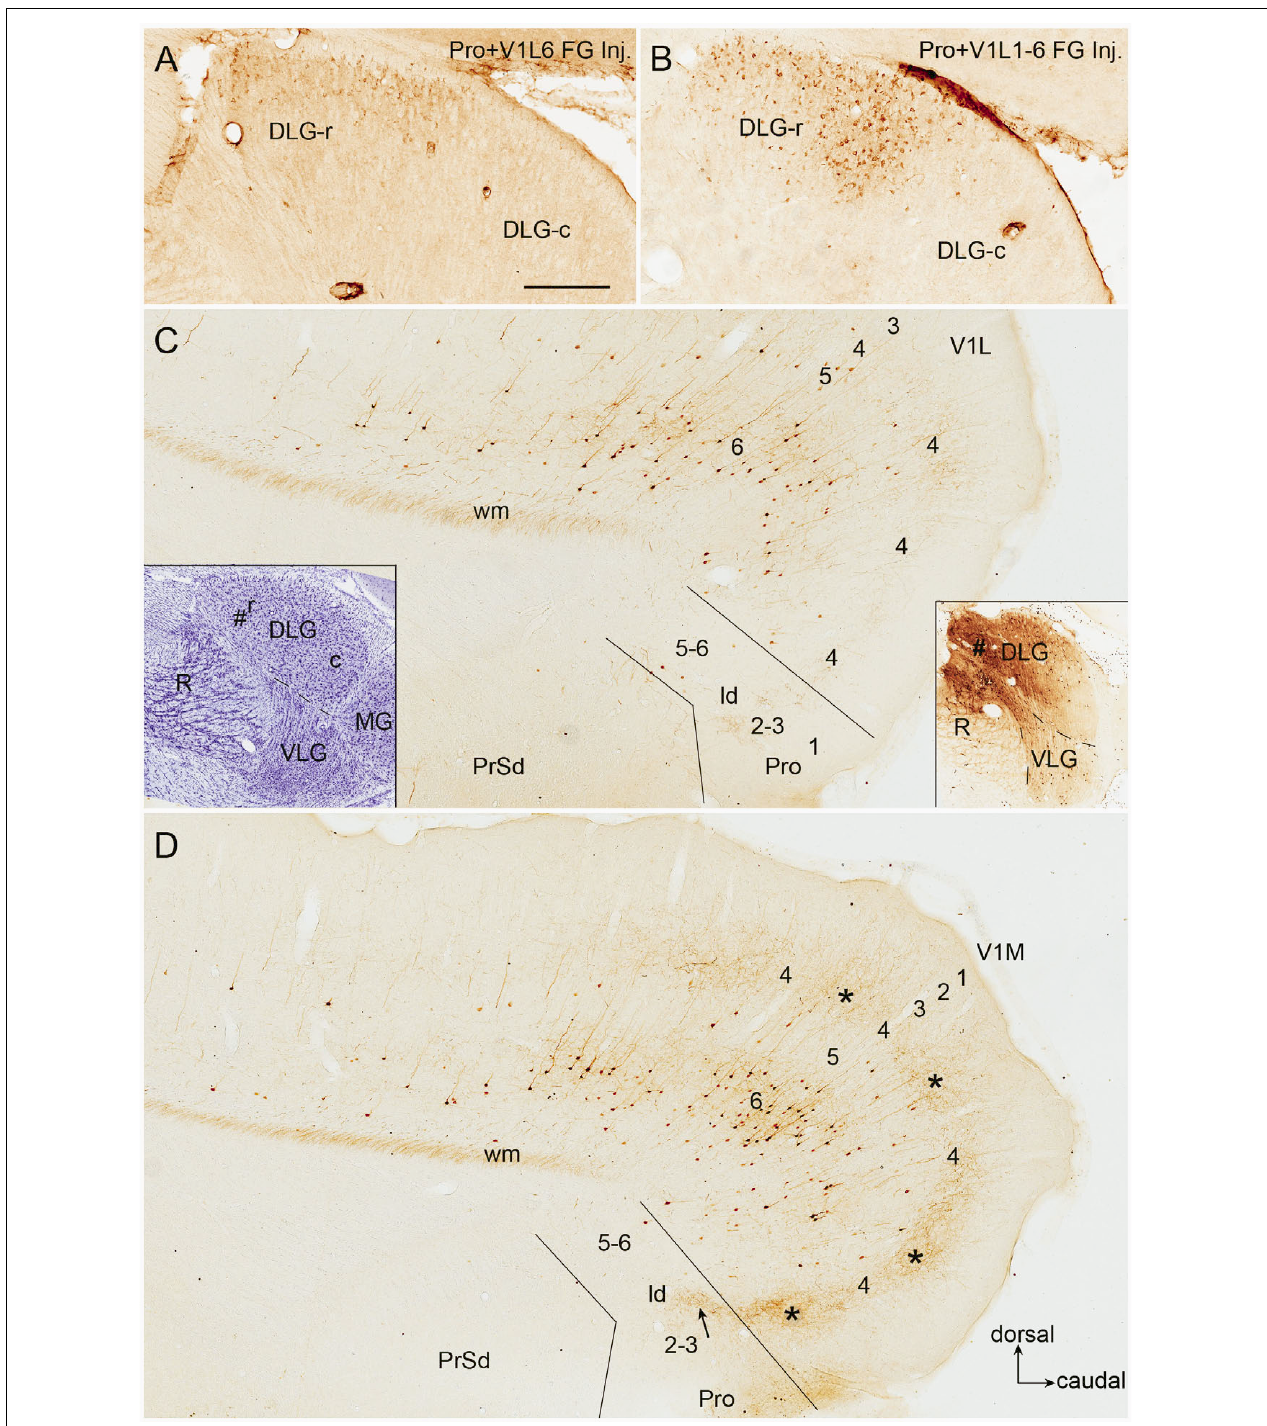
FIGURE 11 | DLG-r projections to area prostriata and V1 in rat. All panels are from sagittal sections. (A,B) Retrogradely labeled neurons in DLG-r following Fluoro-Gold (FG) injections in Pro + V1L6 (A) and Pro + V1 (all layers) (B) . Note that much more neurons ware observed in the DLG-r in (B) . (C,D) Labeled neuronal somata and axon terminals in V1 and prostriata after a biotinylated dextran amine (BDA) injection restricted in the DLG-r (# in the right insets in C ; the left inset shows the locations of the DLG, VLG, R, and MG on a matched Nissl-stained sagittal section). Many retrogradely labeled neurons are observed in layer 6 of V1 with much fewer in layer 5 of V1 and no or few in the prostriata on both lateral (C) and medial (D) sagittal sections. In contrast, labeled axon terminals are mainly seen on the medial section (D) . The labeled terminals mainly distribute in layer 4 and deep layer 3 of V1 with a patchy organization (indicated by the stars in D ) as well as in dorso-caudal portion of lamina dissecans (indicated by the arrow in D